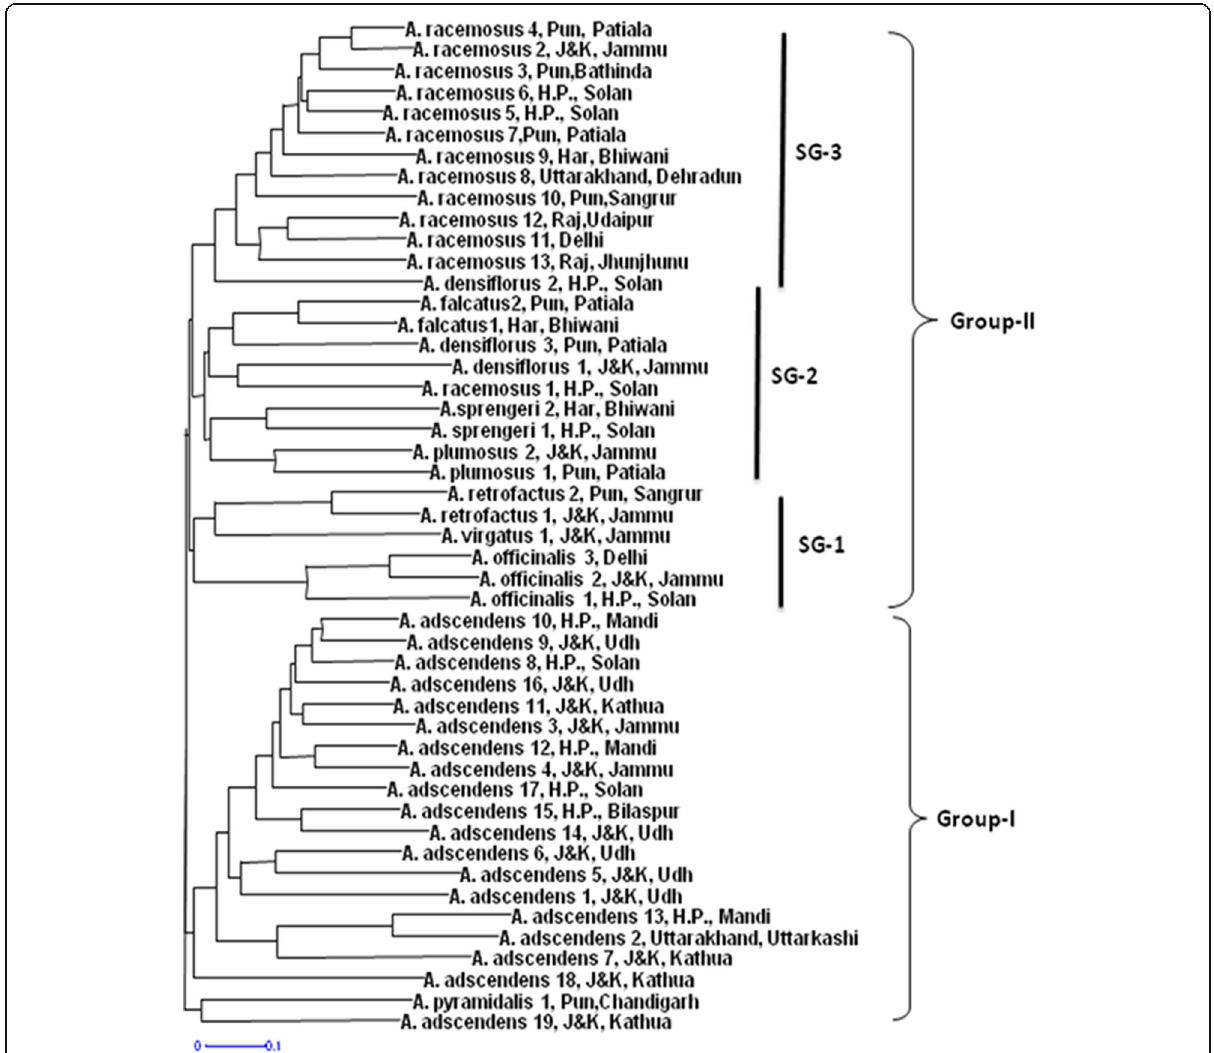
Fig. 2 Dendrogram showing relationships among 10 species of Asparagus . Group I represents the two species A. adscendens and A. pyramidalis while group II represents other eight species in three